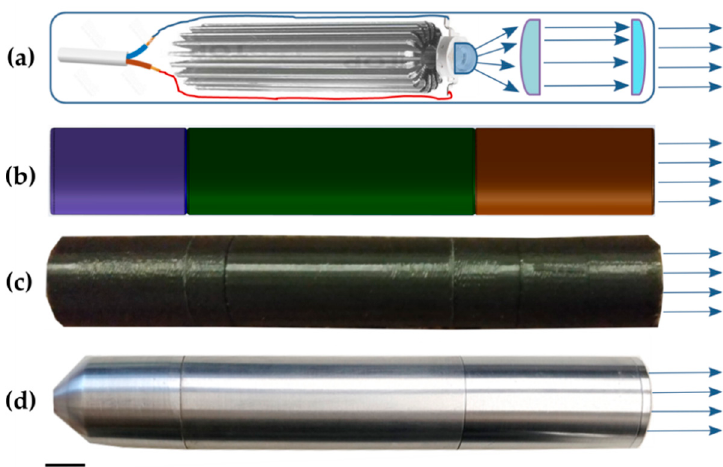
Figure 3. LED light system: ( a ) scheme, that reveals its electrical part, LED, and optical system, ( b ) design of the mounting carcass in 3D Software SOLIDWorks (Dassault Systems, Vélizy-Villacoublay, France), ( c ) 3D printed plastic 1st model, ( d ) final metal model; scale bar corresponds to 10 mm.